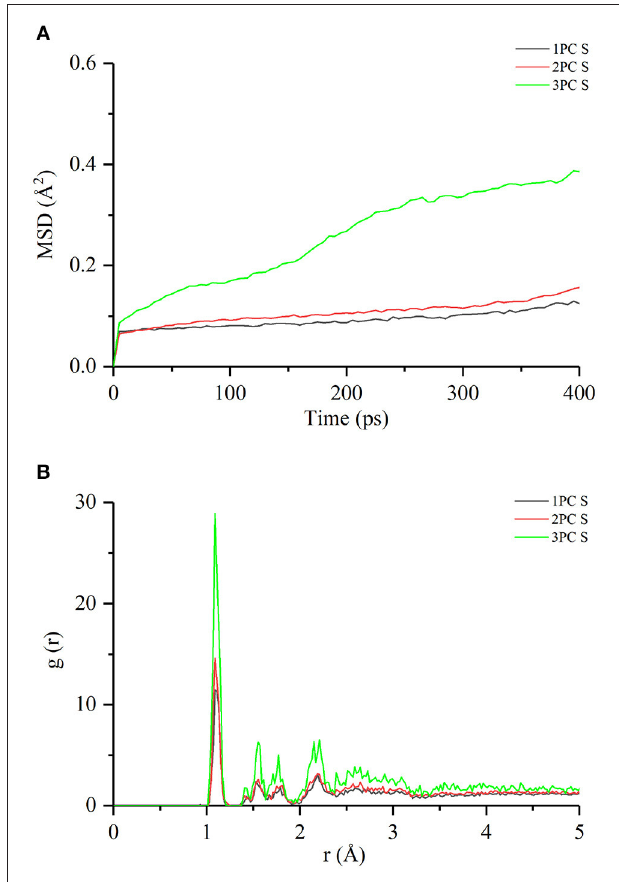
FIGURE 8 | Mean square displacement (A) and radial distribution function (B) of RS with or without LSOPC.